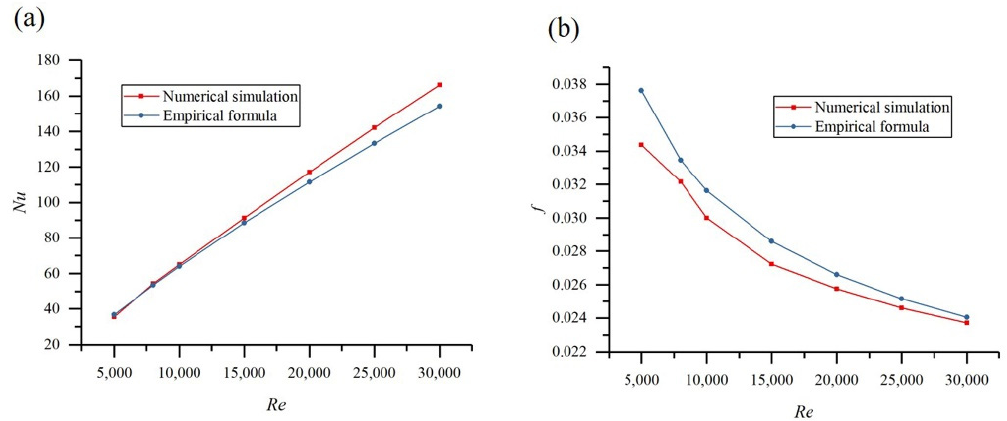
Figure 10. Verification of numerical simulations: ( a ) Nu and ( b ) f.